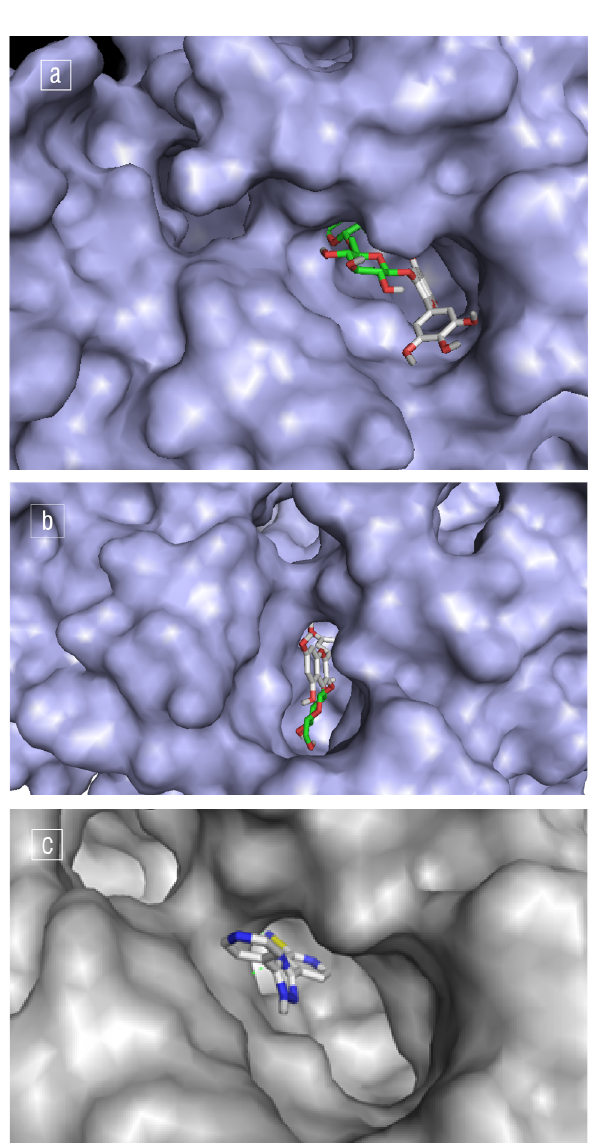
Figure 4: Fittings of (a) dp-3-rhm, (b) cy-3-glu and (c) topiroxostat into the flavin adenine dinucleotide binding site in xanthine oxidase